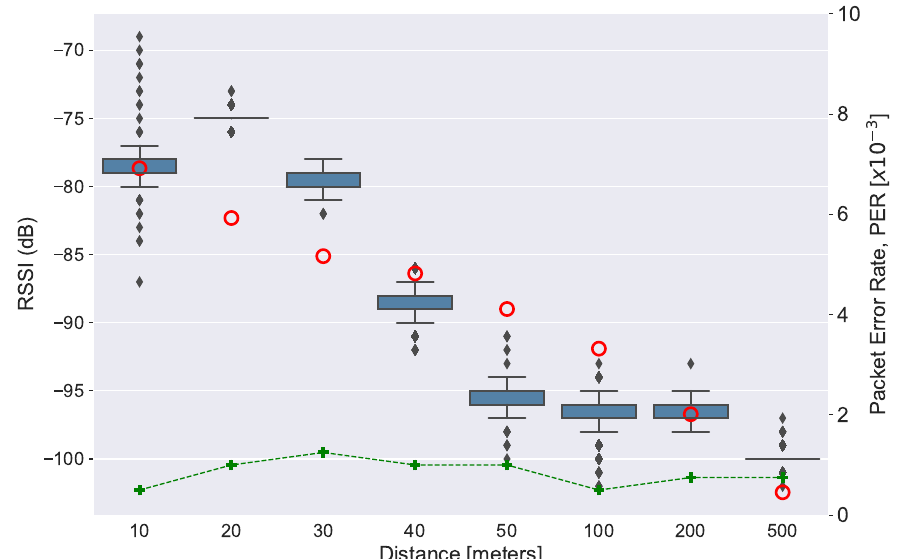
Figure 17. Measurements of RSSI for LoRa operating at 868 MHz with a bandwidth of 125 kHz using SF = 7 and a coding rate of 4/5. The red open circles show the RSSI calculated from the path loss model using a transmission power of 10 dBm and antenna gains of 2 dB at both ends. The green curve shows the measured packet error rate in the